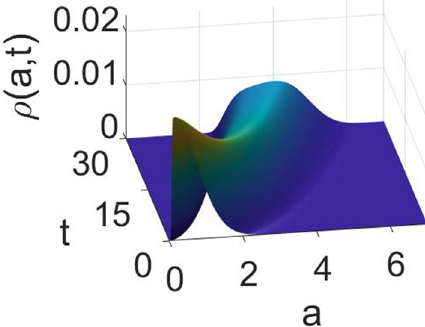
Fig. 2 Three-dimensionalgraphicfortheevolutionofthewavepacket. The parameters are taken as: p a = 10, α = 0 . 5, V 0 = 200